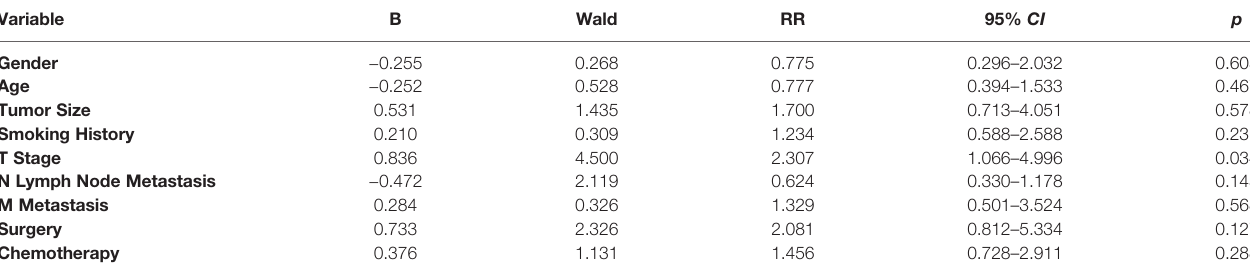
TABLE 2 | Multivariate Cox Model Analysis of Effects on Pulmonary Sarcomatoid Carcinoma (PSC) Prognosis.